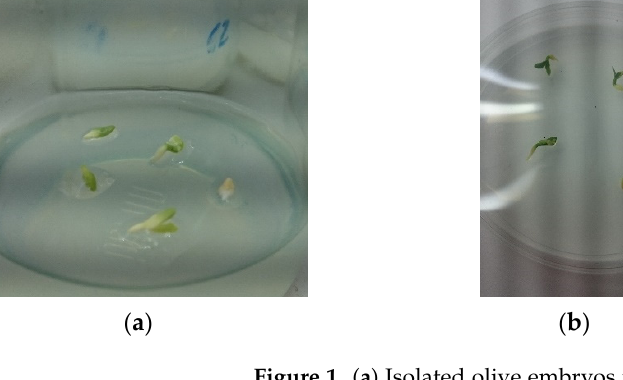
Figure 1. ( a ) Isolated olive embryos in vitro established after 5 days; ( b ) Germination of embryos after 10 days from establishment; ( c ) Plantlets developed from embryos at 21 days of cultivation. Table 3. Germination rates detected on the two types of media tested related to isolated olive embryos of the cross combination 5 (Leccino × FS 17) of the 2017 season.